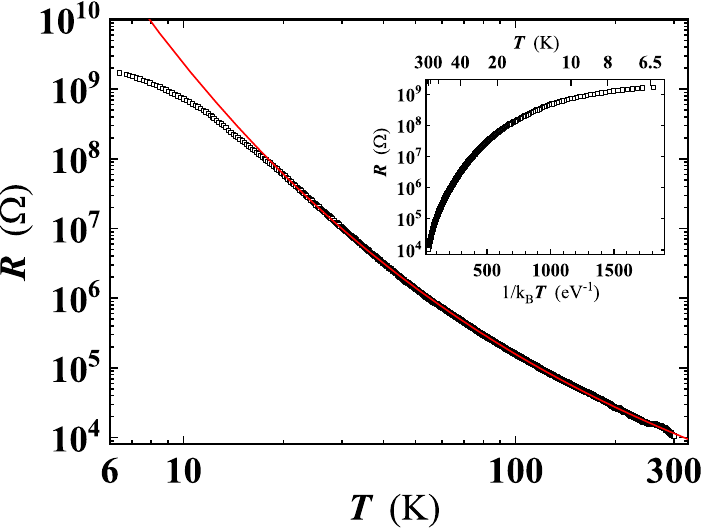
Figure 9. Resistance of the investigated GS as a function of temperature. Red line is the least-squares fit by Equation (4). Inset: Arrhenius plot of the same R ( T ) curve. With decreasing temperature, we have found a rise up to 5 orders of magnitude in the resistance. In the sample shown in Figure 9, R increases from (cid:39) 10 4 Ω at RT to (cid:39) 2 × 10 9 Ω at (cid:39) 6 K, confirming the dominantly insulating character of the material. The Arrhenius plot of R ( T ) shows a monotonic decrease of the curve slope with lowering temperature (see the inset of Figure 9), excluding the thermally activated conduction as a mechanism for charge carriers transport in this system. The large variation of R ( T ) , in the considered temperature range, can be explained by local non-uniformity of the C:O ratio, resulting